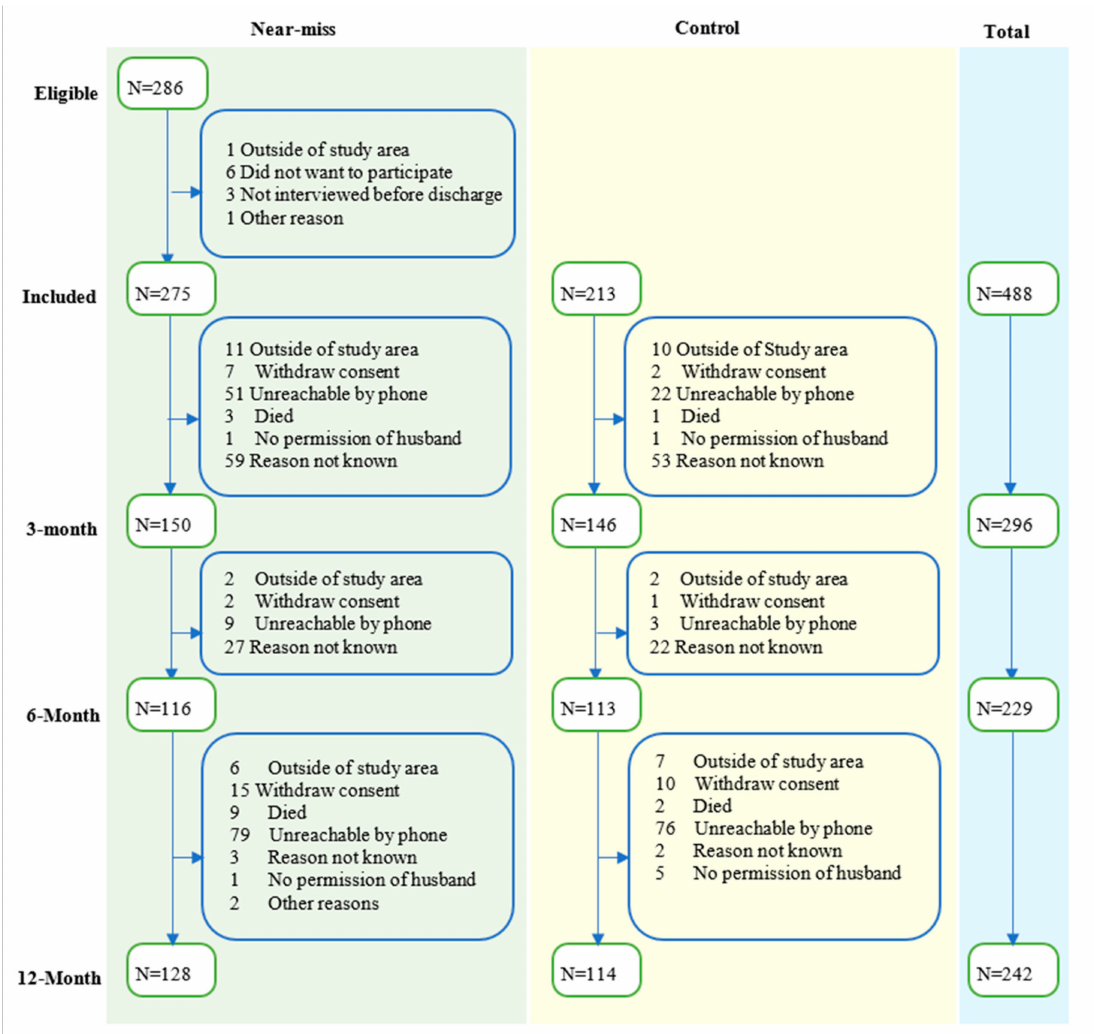
Figure 1. Flowchart of eligibility, inclusion, and follow-up of participants. Table 1. Baseline demographic and clinical characteristics of participants included in the study